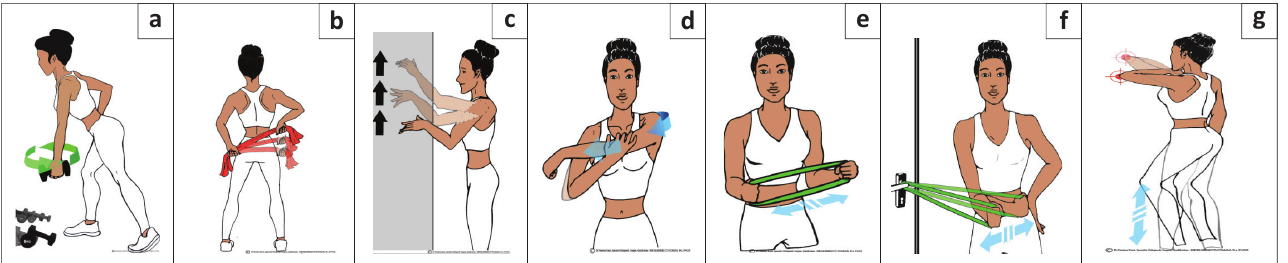
FIGURE 2: Home-based programme for shoulder stretching and strengthening exercises. (a) Pendulum stretch exercise: Perform 10 revolutions in each direction, once a day. Increase the stretch by holding a light weight (1 kilograms [kg] – 2 kg) in the swinging arm. (b) Towel stretch exercise: One end of a long enough towel is held behind your back in your affected hand and grab the opposite end with your other hand. Hold the towel in a horizontal position. Use your good arm to pull the affected arm upward to stretch it. Perform this stretch 15–30 times once a day. (c) Finger walk exercise: Reach out and touch the wall at waist level with the fingertips of the affected arm. With your elbow slightly bent, slowly walk your fingers up the wall, until you have raised your arm as far as you comfortably can. Slowly lower the arm (with the help of the good arm, if necessary). Perform this exercise 15–30 times a day. (d) Cross-body stretch: Use your good arm to lift your affected arm at the elbow, bring it up and across your body, and apply gentle pressure to stretch the shoulder. Hold the stretch for 15–20 s, 15–30 times per day. (e) Outward strengthening: Strengthening begins once range improves. Hold a rubber exercise band between your hands with your elbows at a 90-degree angle close to your sides. Rotate the lower part of the affected arm outward 15–20 degrees, and hold for 5 s. Repeat 15–20 times, once a day. (f) Inward strengthening: Hook an elastic loop band onto a closed door handle. Hold the other loop end of the elastic band with your hand on the affected side with your elbow flexed 90 degrees and arm at your side. Pull the band inward toward your tummy as far as possible and hold for 5 s. Repeat this 15–20 times, once a day. (g) Armpit stretch/elbow walk: Reach out and touch the wall at waist level with the flexed elbow of the affected arm. Slowly walk your elbow up the wall, until you have raised your arm as far as you comfortably can. Your elbow tip should be doing the work, not your shoulder muscles. Slowly lower the arm (with the help of the good arm, if necessary), and repeat. Repeat this exercise 15–30 times a